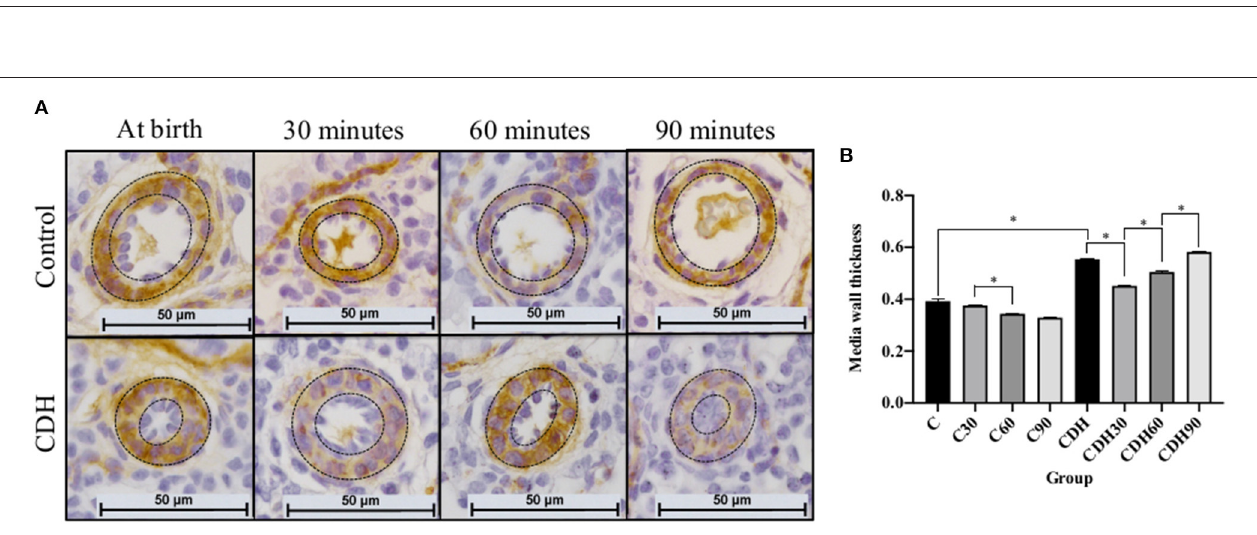
FIGURE 1 | Nitrofen-induced CDH decreases birth weight and causes pulmonary hypoplasia. Newborn rats with nitrofen-induced CDH had lower body weight, left lung weight, total lung weight, total lung weight to body weight ratio (TLW/BW), and left lung weight to body weight ratio (LLW/BW). C, control; C30, control ventilated for 30min; C60, control ventilated for 60min; C90, control ventilated for 90min; CDH, congenital diaphragmatic hernia; CDH30, CDH ventilated for 30min; CDH60, CDH ventilated for 60min; CDH90, CDH ventilated for 90min. * p < 0.05.